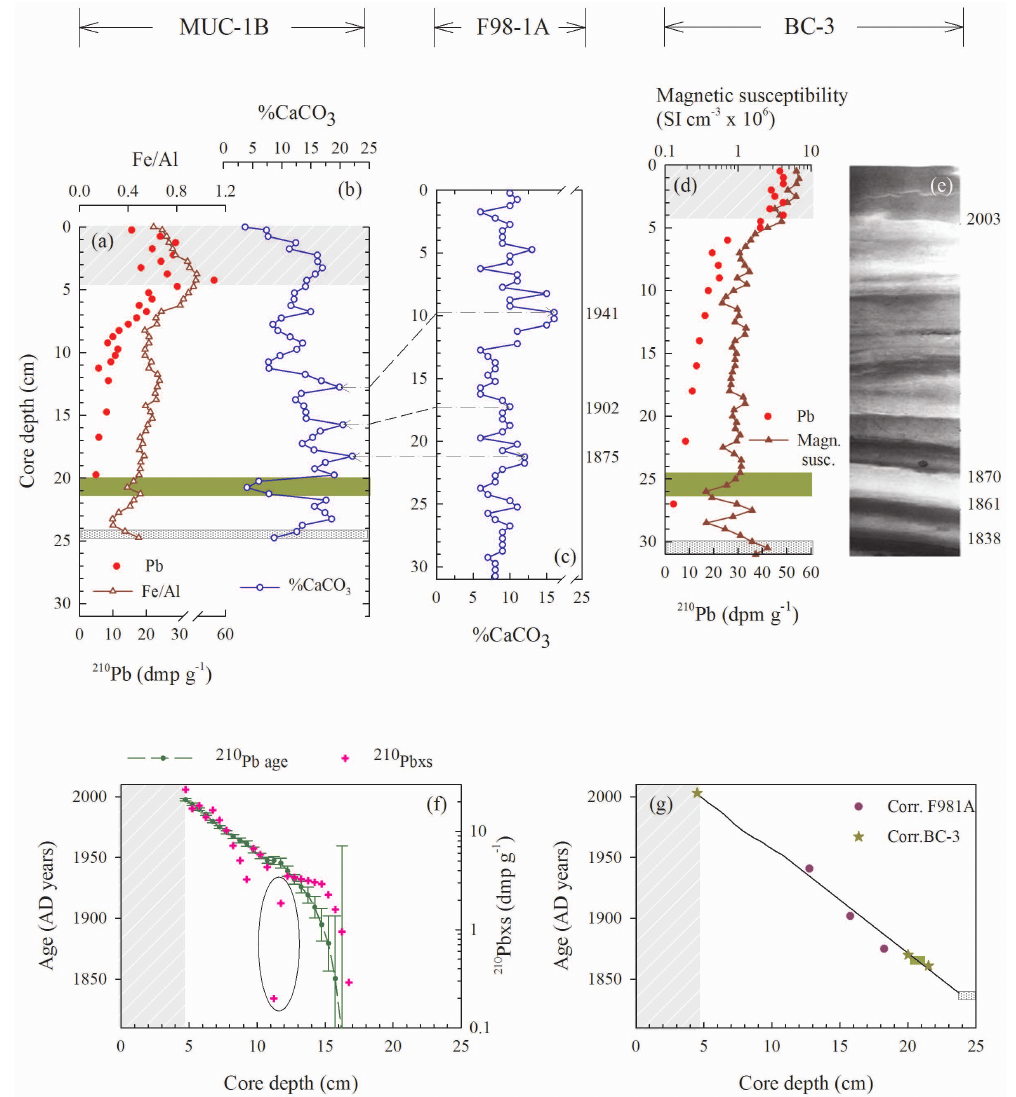
Fig. 2. Fe/Al and 210 Pb activity for core MUC-1B (a) , calcium carbonate content (%CaCO 3 ) for core MUC-1B (b) and core F98-1A (c) , magnetic susceptibility and 210 Pb activity for core BC-3C (d) , contact print of core BC-3D (e) , age model estimated from 210 Pb excess ( 210 Pb xs ) with the constant rate of supply model for core MUC-1B, including error bars representing ± one standard deviation (f) , and final integrated age model for core MUC-1B, including the upper 10cm 210 Pb activities and stratigraphic correlation with cores BC-3 and F98-1A (g) . Green areas in (a) (b), (d) , and (g) correspond to the “spongy layer”, whereas the cross-hatched area in the same figures represents harbor construction work starting December 2002; the shaded grey area in (d) represents the 1836 earthquake. The stars in (g) represent ages from core F98-1A obtained by correlation of %CaCO 3 with core MUC-1B. Ages in (c) and (e) were obtained from the original age models for core F98-1A (Vargas et al., 2007) and core BC-3D (Caniup´an et al., 2009), respectively. In (f) , extreme non-steady state 210 Pb activities are enclosed within an